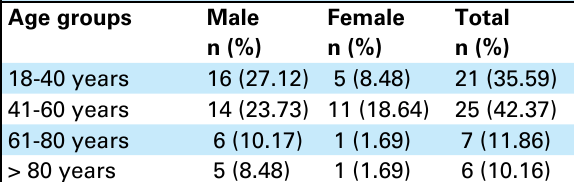
Table 1. Distribution of age and gender in patients with increased GSV diameter (n=